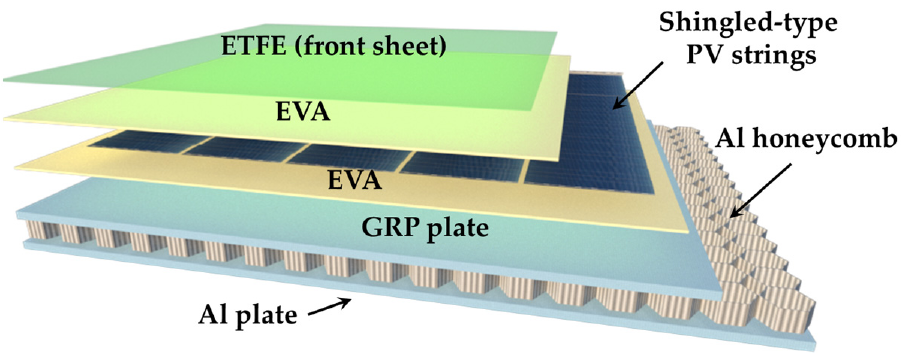
Figure 2. Schematic of the shingled-type lightweight glass-free solar module.